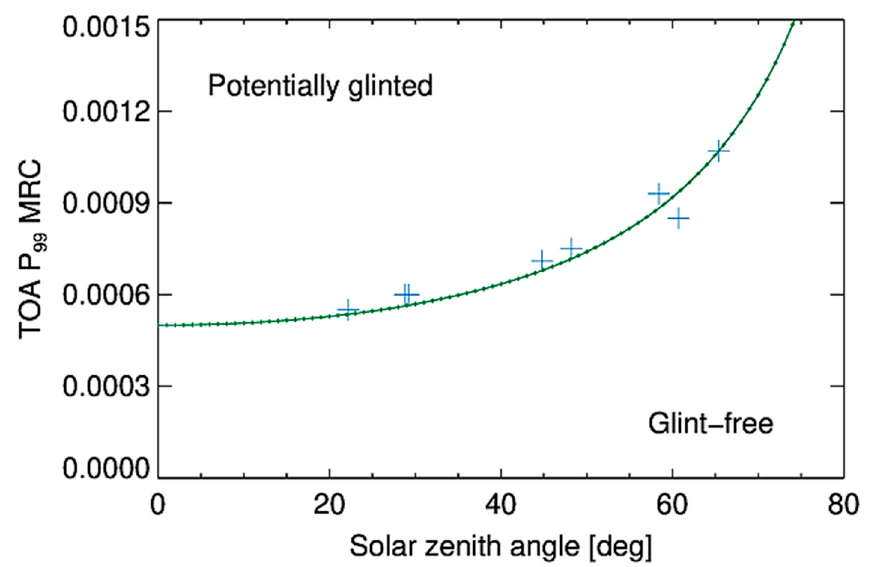
Figure 3. P 99 of the maximum reflectance contrast (MRC) in OLI channel B7 for eight glint-free areas as a function of the solar zenith angle. The fit represents threshold THR PGP in Equation (4) above which a pixel is considered potentially sun glint affected.